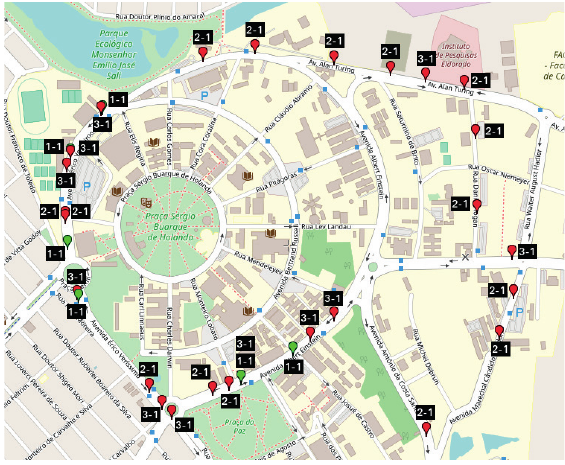
Figure 9. Map created with MLP.